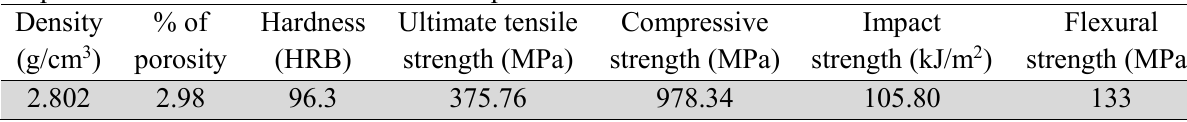
Properties of the T6 conditioned AMC